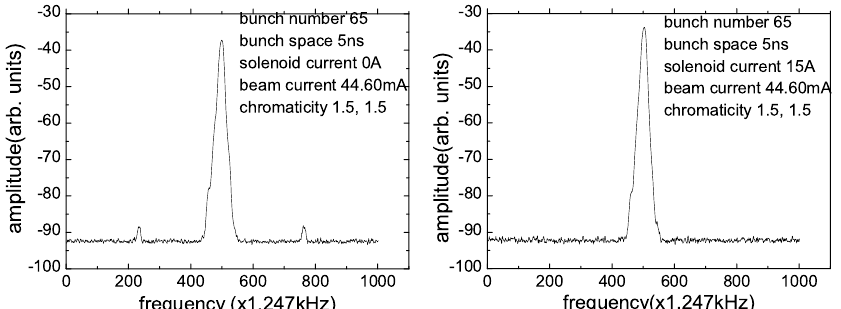
FIG. 5. Solenoid effect on vertical betatron sidebands (left: solenoid off; right: solenoid